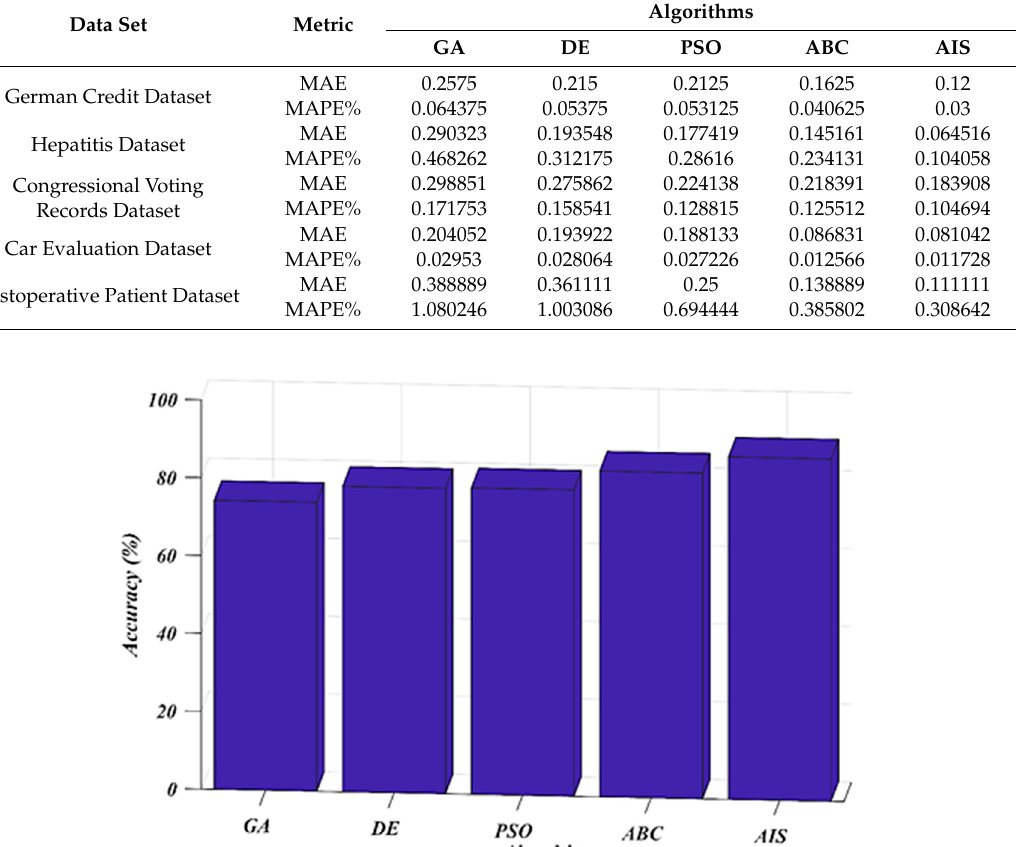
Table 3. Testing Error for Real Datasets.